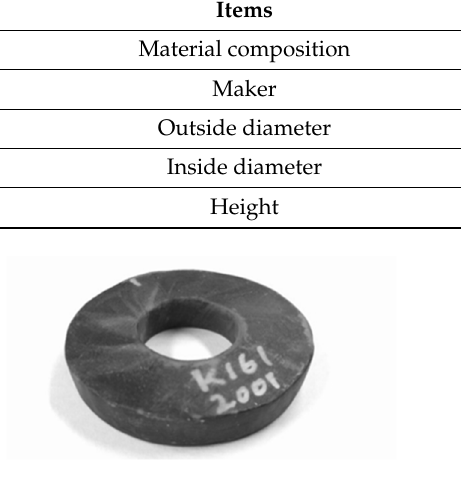
Table 1. Specifications of the HTS.